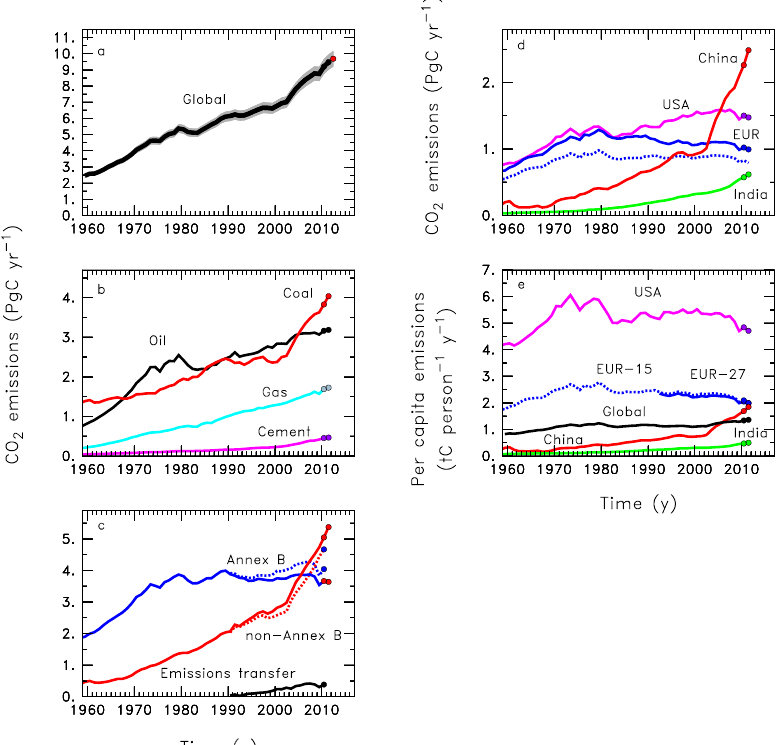
Figure 4. CO 2 emissions from fossil fuel combustion and cement production for (a) the globe, including an uncertainty of ± 5% (grey shading), the emissions extrapolated using BP energy statistics (black dots) and the emissions projection for year 2012 based on GDP projection (red dot), (b) global emissions by fuel type, including coal (red), oil (black), gas (light blue), and cement (purple), and excluding gas flaring which is small (0.7% in 2011), (c) territorial (full line) and consumption (dashed line) emissions for the countries listed in the Annex B of the Kyoto Protocol (blue lines; mostly advanced economies with emissions limitations) versus non-Annex B countries (red lines), also shown are the emissions transfer from non-Annex B to Annex B countries (black line) (d) territorial CO 2 emissions for the top three country emitters (USA – purple; China – red; India – green) and for the European Union (EU; full blue for the 27 states members of the EU in 2011; dash blue for the 15 states members of the EU in 1997 when the Kyoto Protocol was signed), and (e) per-capita emissions for the top three country emitters and the EU (all colours as in panel d ). In panels (b) to (e) , the dots show the years where the emissions were extrapolated using BP energy statistics. All time series are in PgCyr − 1 except the per-capita emissions (panel e ), which are in tonnes of carbon per person per